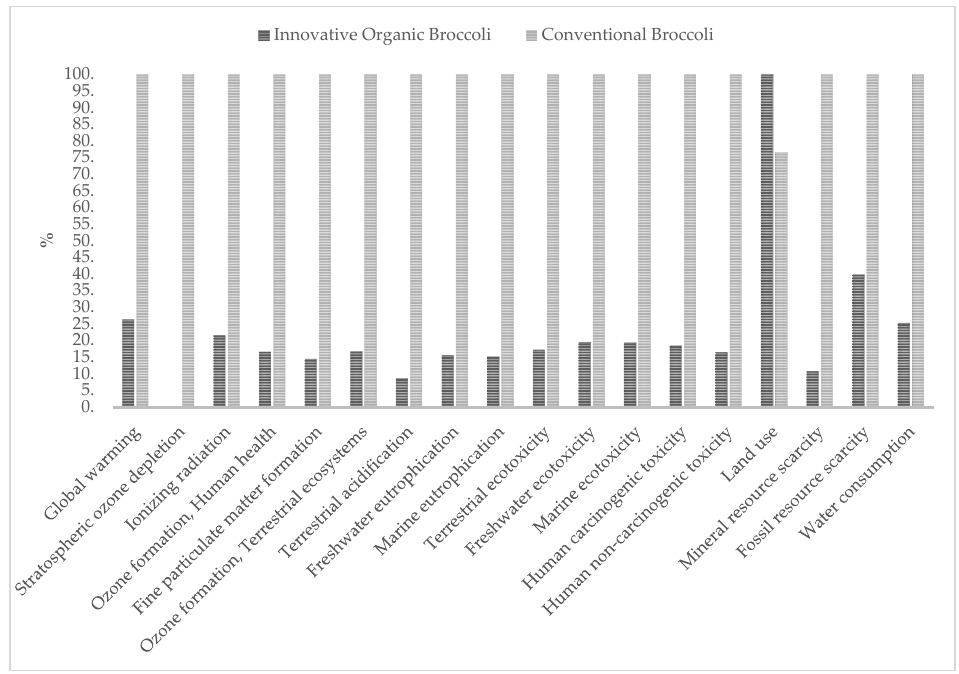
Figure 2. Impact comparison of innovative organic and conventional broccoli per ha of cultivated area (% of average value for each category). (Our elaboration on SimaPro 9.1 software). Agronomy 2023 , 13 , x FOR PEER REVIEW